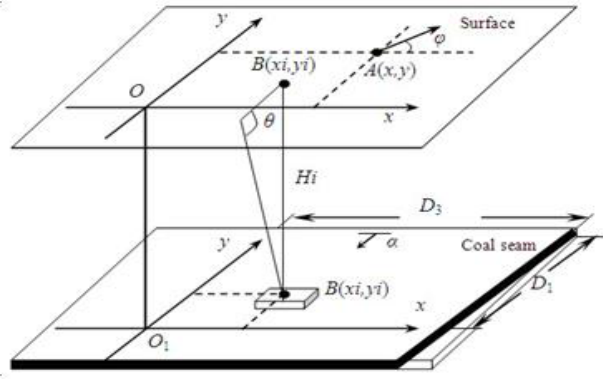
Figure 1. Spatial coordinate system of mining The key to predict surface mining subsidence by probability integral method is to determine the subsidence coefficient ( q) , the tangent of main influence angle (tanβ), the mining influence angle ( θ ) and horizontal movement coefficient b (this defaults to the common value of 0.3). These parameters are mainly inversed by a certain amount of surface movement monitoring